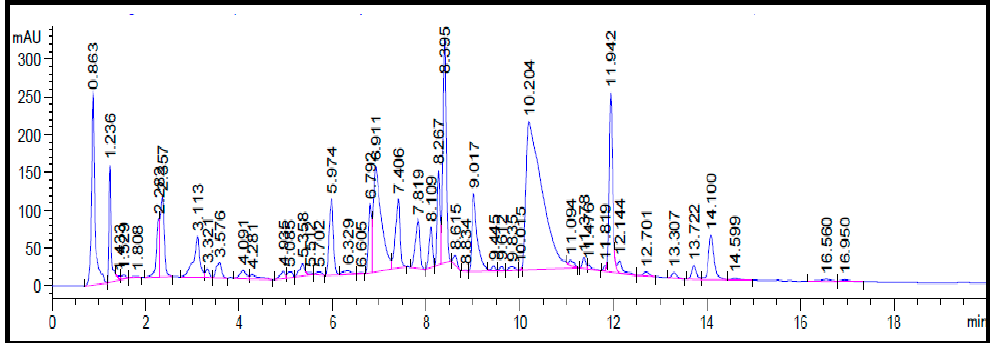
Figure 4. Ultra-performance liquid chromatography (UPLC) Chromatogram profile of E. alba crude Figure 4. Ultra ‐ performance liquid chromatography (UPLC) Chromatogram profile of E. alba crude extract at 260 nm. extract at 260